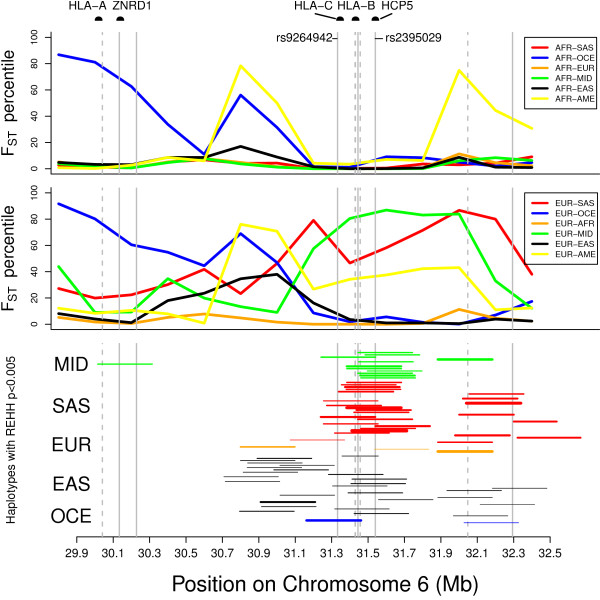
Sliding window analysis (400 Kb window with 200 Kb overlapping) of FST percentile in relation to random regions on chromosome 6 for all AFR pairwise comparisons (top panel) and for all EUR pairwise comparisons (middle panel). The lower panel shows all haplotypes in region with REHH p < 0.005, and core frequency greater than 5%, for each group. Thickness of lines is weighted by core haplotype frequency. AFR and AME are not shown in the lower panel because these groups had no qualifying haplotypes. Loci associated with HIV-1 VL set-point are shown as vertical lines (solid for EA, dotted for AA). Locations of genes of interest are shown in the top of the figure. (AFR: sub-Saharan Africa; MID: Middle East; SAS: South Asia; EUR: Europe; EAS: East Asia; OCE: Oceania; AME: Americas)